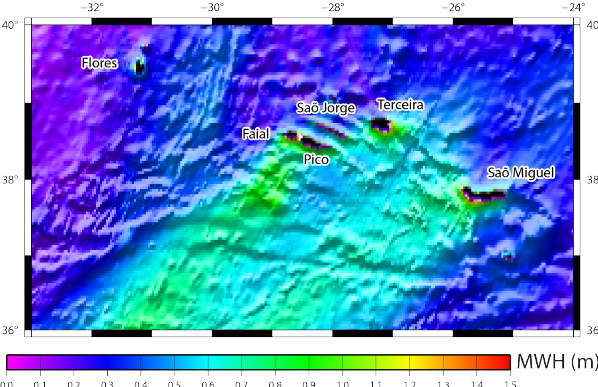
Figure 4. Maximum wave heights map over the bathymetric grid of the Azores archipelago (grid 2) after 12h of tsunami propagation corresponding to the 1843-like scenario (no.